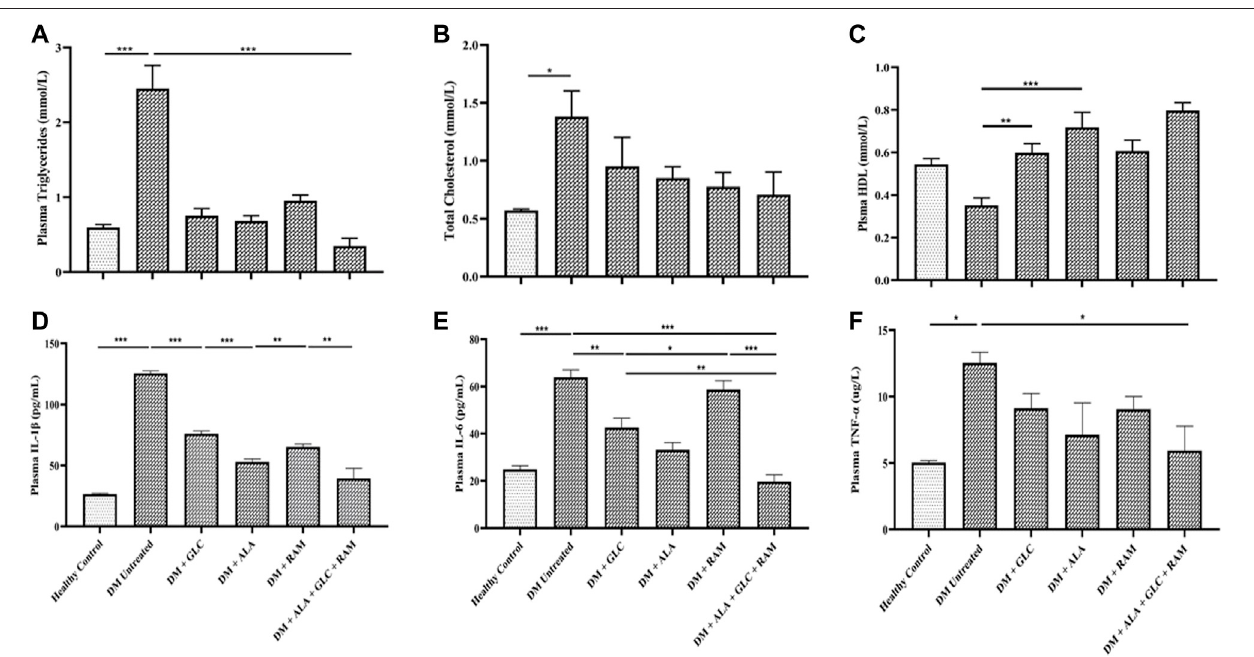
FIGURE 3 | Lipid pro fi le and in fl ammation. Levels of (A) plasma plasma triglycerides, (B) total cholesterol, (C) plasma high-density lipoprotein (HDL), (D) plasma interleukin-1beta (IL-1 β ), (E) plasma interleukin-6 (IL-6) and (F) plasma tumor necrosis factor-alpha (TNF- α ). Healthy control ( n = 7); DM Untreated = Untreated diabetes mellitus rats ( n = 9); DM + GLC = Diabetic rats treated with gliclazide ( n = 7); DM + ALA = Diabetic rats treated with alpha-lipoic acid ( n = 7); DM + RAM = Diabetic rats treatedwithramipril( n =7);DM +ALA+GLC+RAM=Diabeticratstreatedwithalpha-lipoicacid,gliclazideandramipril( n =7).* p < 0.05vs. diabetic control,** p